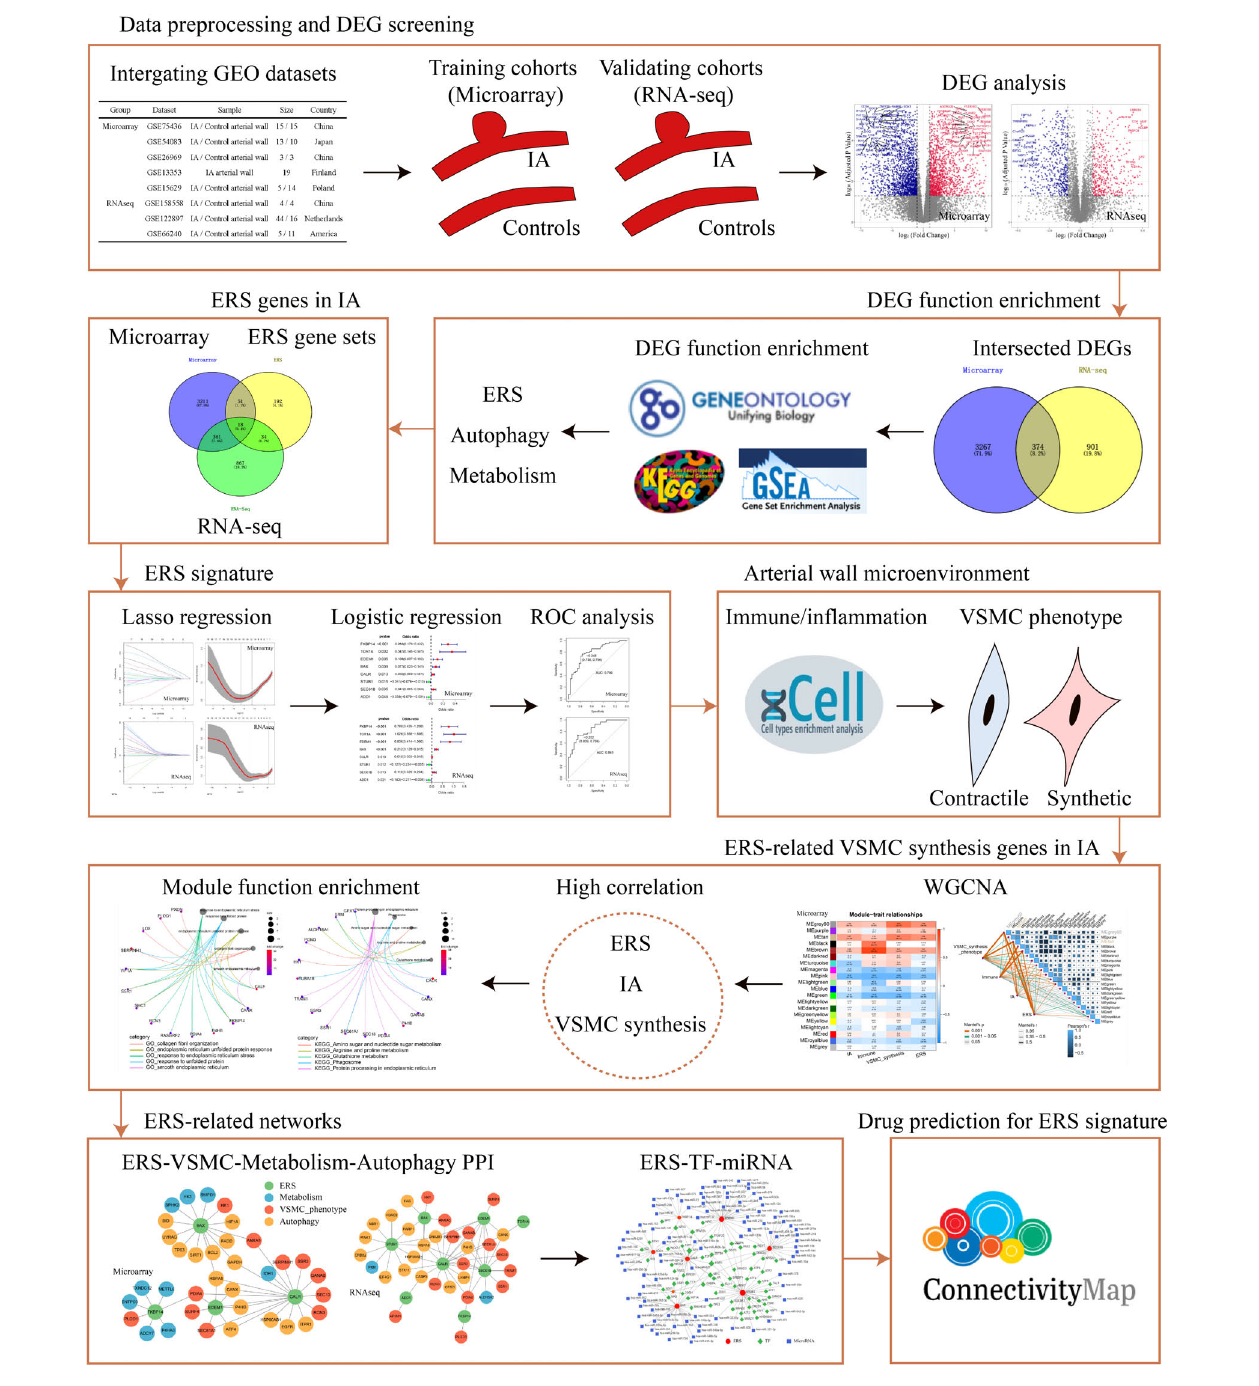
FIGURE 1 | The flow chart of data analysis. DEG, differential expression gene; RNA-seq, RNA sequencing; ERS, endoplasmic reticulum stress; ROC, receiver operating characteristic; VSMC, vascular smooth muscle cell; PPI, protein–protein Interaction; TF, transcription factor.